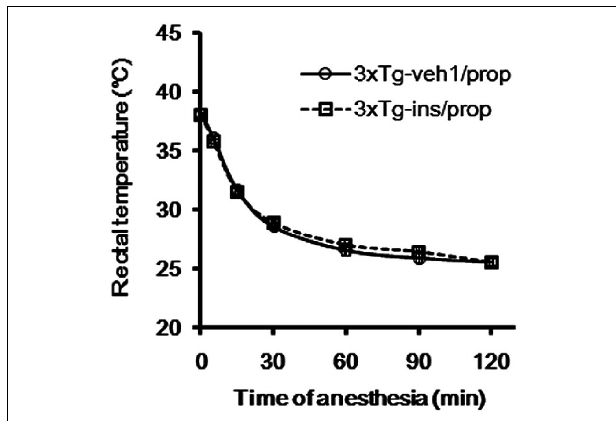
FIGURE 3 |Alteration of rectal temperature during anesthesia of the 3xTg-AD mice.